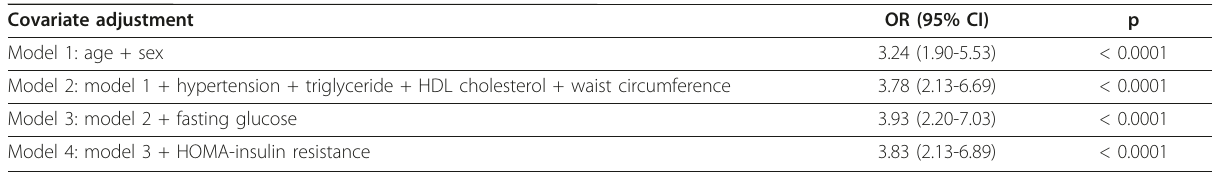
Table 3 Multiple logistic regression analysis of the association of the G319S carrier status in HNF1A with the incidence of type 2 diabetes